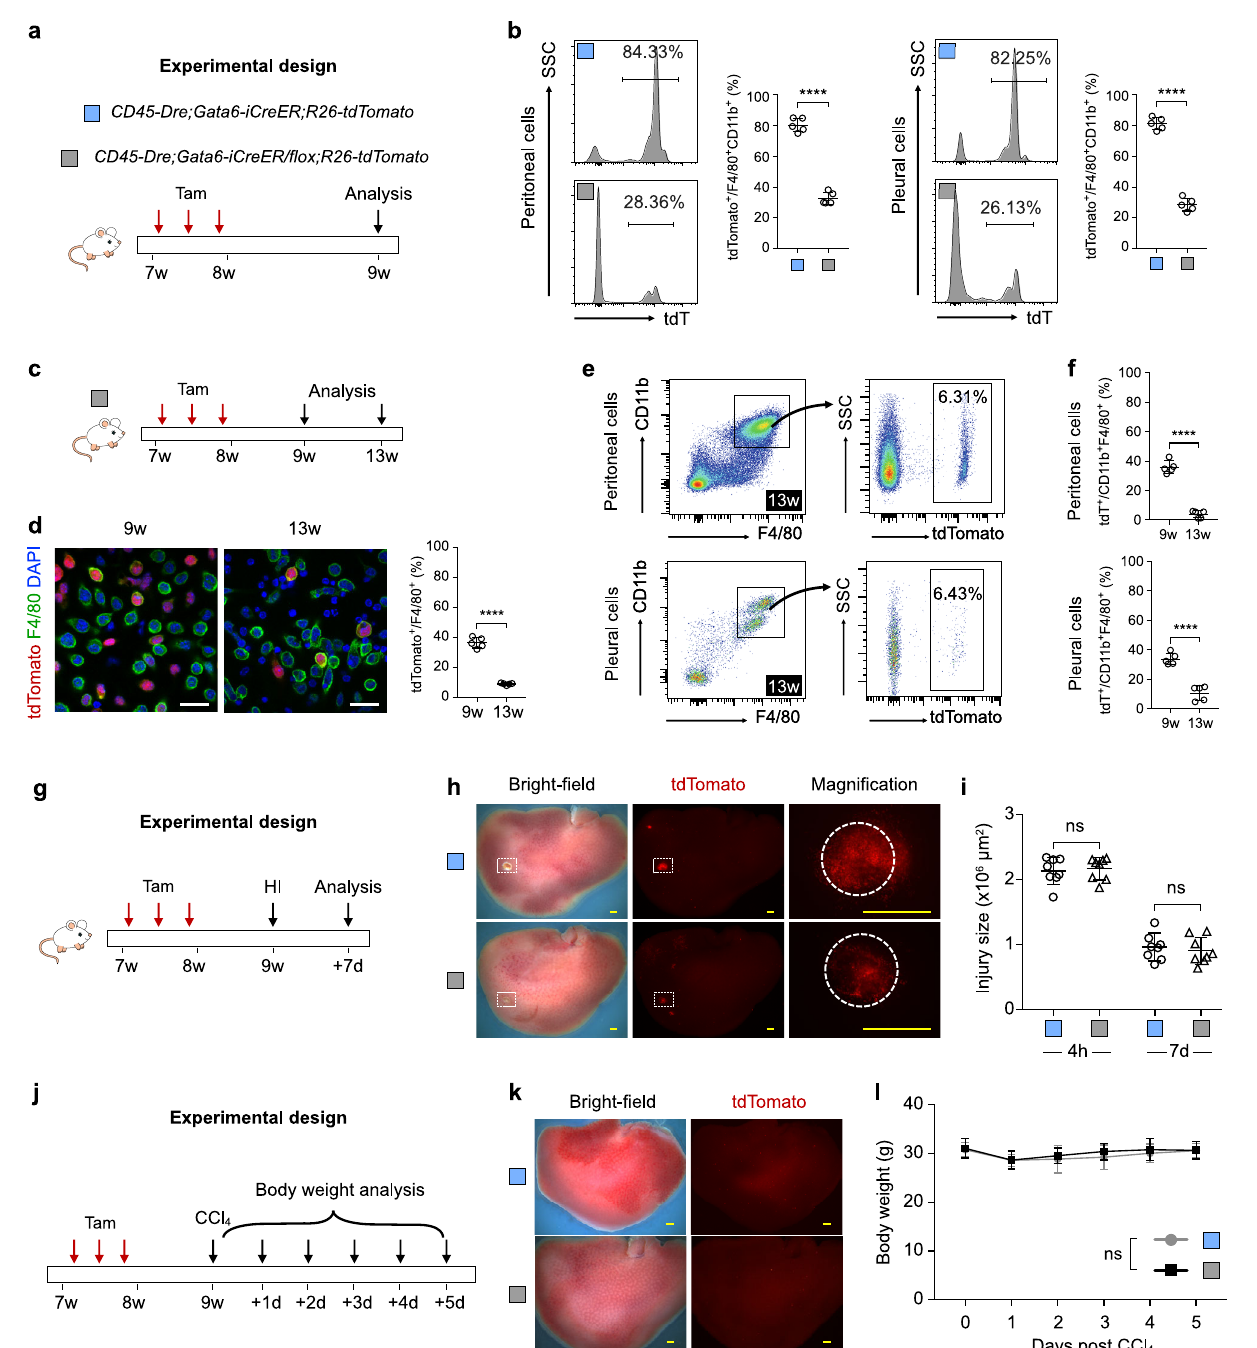
Fig. 5 Gata6 deletion in cavity macrophages did not affect injury repair in the liver. a Schematic fi gure showing the experimental design. b Flow cytometric and quanti fi cation analysis of the percentage CD11b + F4/80 + macrophages expressing tdTomato from the pleural and peritoneal cavity. Data are the mean ± SD; n = 5 mice per group; **** P < 0.0001. c Schemati c fi gure showing the experimental design. d Immunostaining for tdTomato and F4/80 on dissociated cells from peritoneal cavity at 9 weeks and 13 weeks after TAM. Data are the mean ± SD; n = 5 mice per group. **** P < 0.0001. Each image is representative of fi ve individual biological samples. e , f Flow cytometric analysis and quanti fi cation of the percentage of CD11b + F4/80 + macrophages expressing tdTomato. Data are the mean ± SD; n = 5 mice per group; **** P < 0.0001. g Schematic fi gure showing the experimental design. HI heat injury. h Whole-mount bright- fi eld and fl uorescence images of livers collected at 7 days after heart injury. Boxed regions are magni fi ed; circles, heat injury site. Each image is representative of eight individual biological samples. i Quanti fi cation of injury size at 4 h and 7 days post HI. Data are the mean ± SD; n = 8 mice per group; ns nonsigni fi cant. j Schematic fi gure showing the experimental design. k Whole-mount bright- fi eld and fl uorescence images of livers collected at 5 days after injury. Each image is representative of fi ve individual biological samples. l Quanti fi cation of body weight at different days after CCl 4 treatment. Data are the mean ± SD; n = 5 mice per group; ns, non-signi fi cant. Scale bars: yellow, 1 mm; white, 100 µ m. P value was calculated by unpaired two-sided Student ’ s t test ( b , d , f , i ) or two-way ANOVA coupled with multiple comparisons ( l ). Source data are provided as a Source Data fi le.